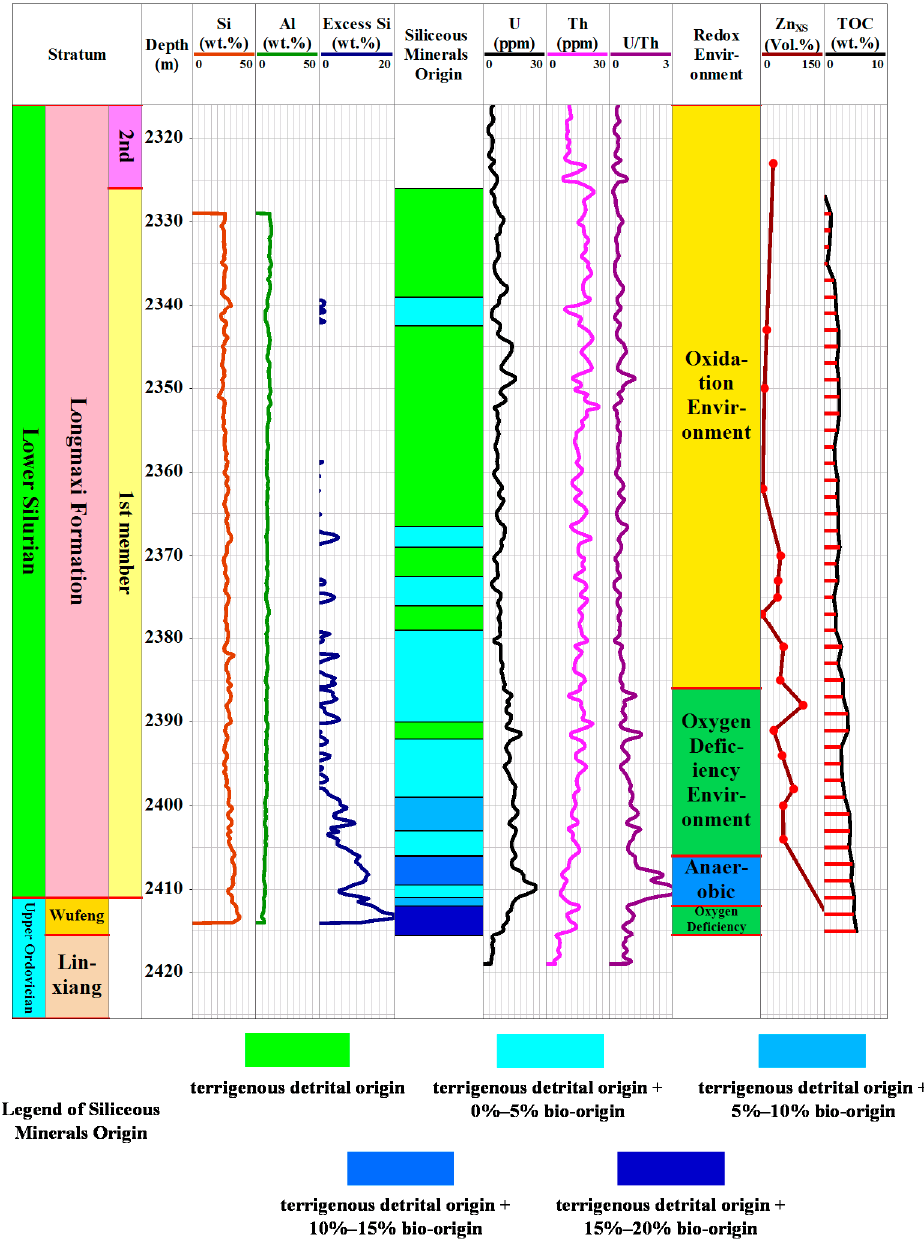
Figure 2. Excess silicon, redox environment, bio-productivity (Zn xs ), and TOC content of Jiaoye-1 well in the Upper Ordovician Wufeng Formation–Lower Silurian no. 1 section of the Longmaxi Formation in the Yangtze area. See Figure 1 for the well location.